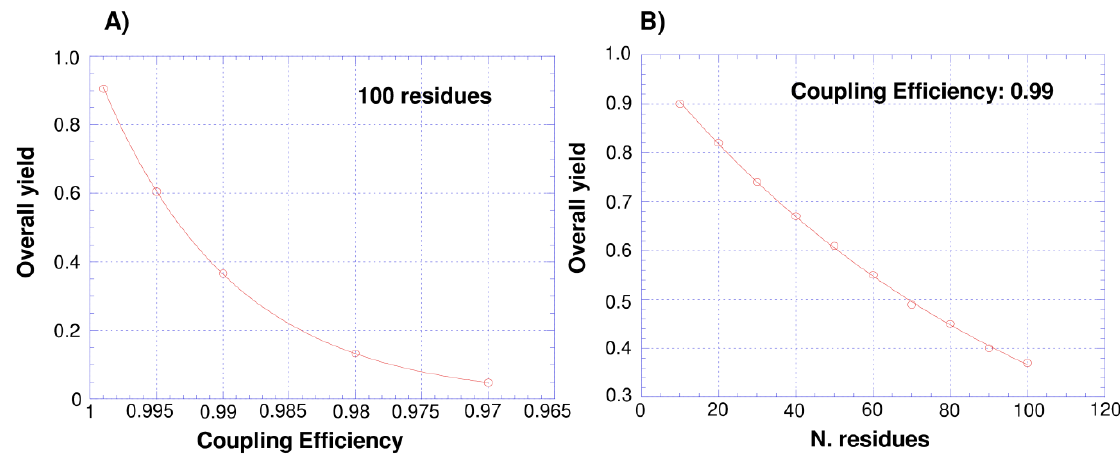
Figure 1. Dependence of stepwise SPPS yield on coupling efficiency ( A ) and number of coupling steps ( B